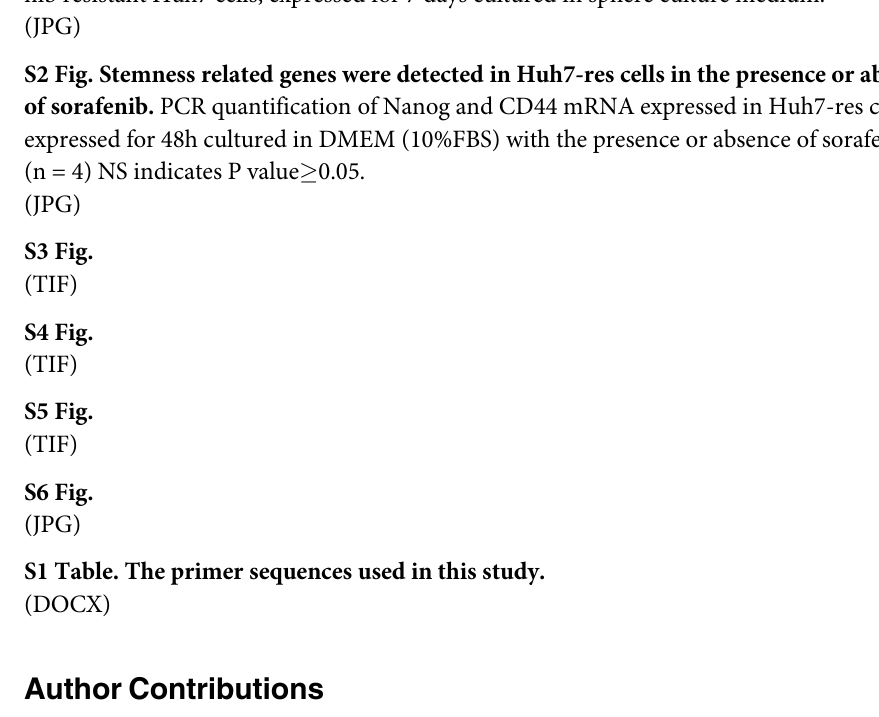
S1 Table. The primer sequences used in this